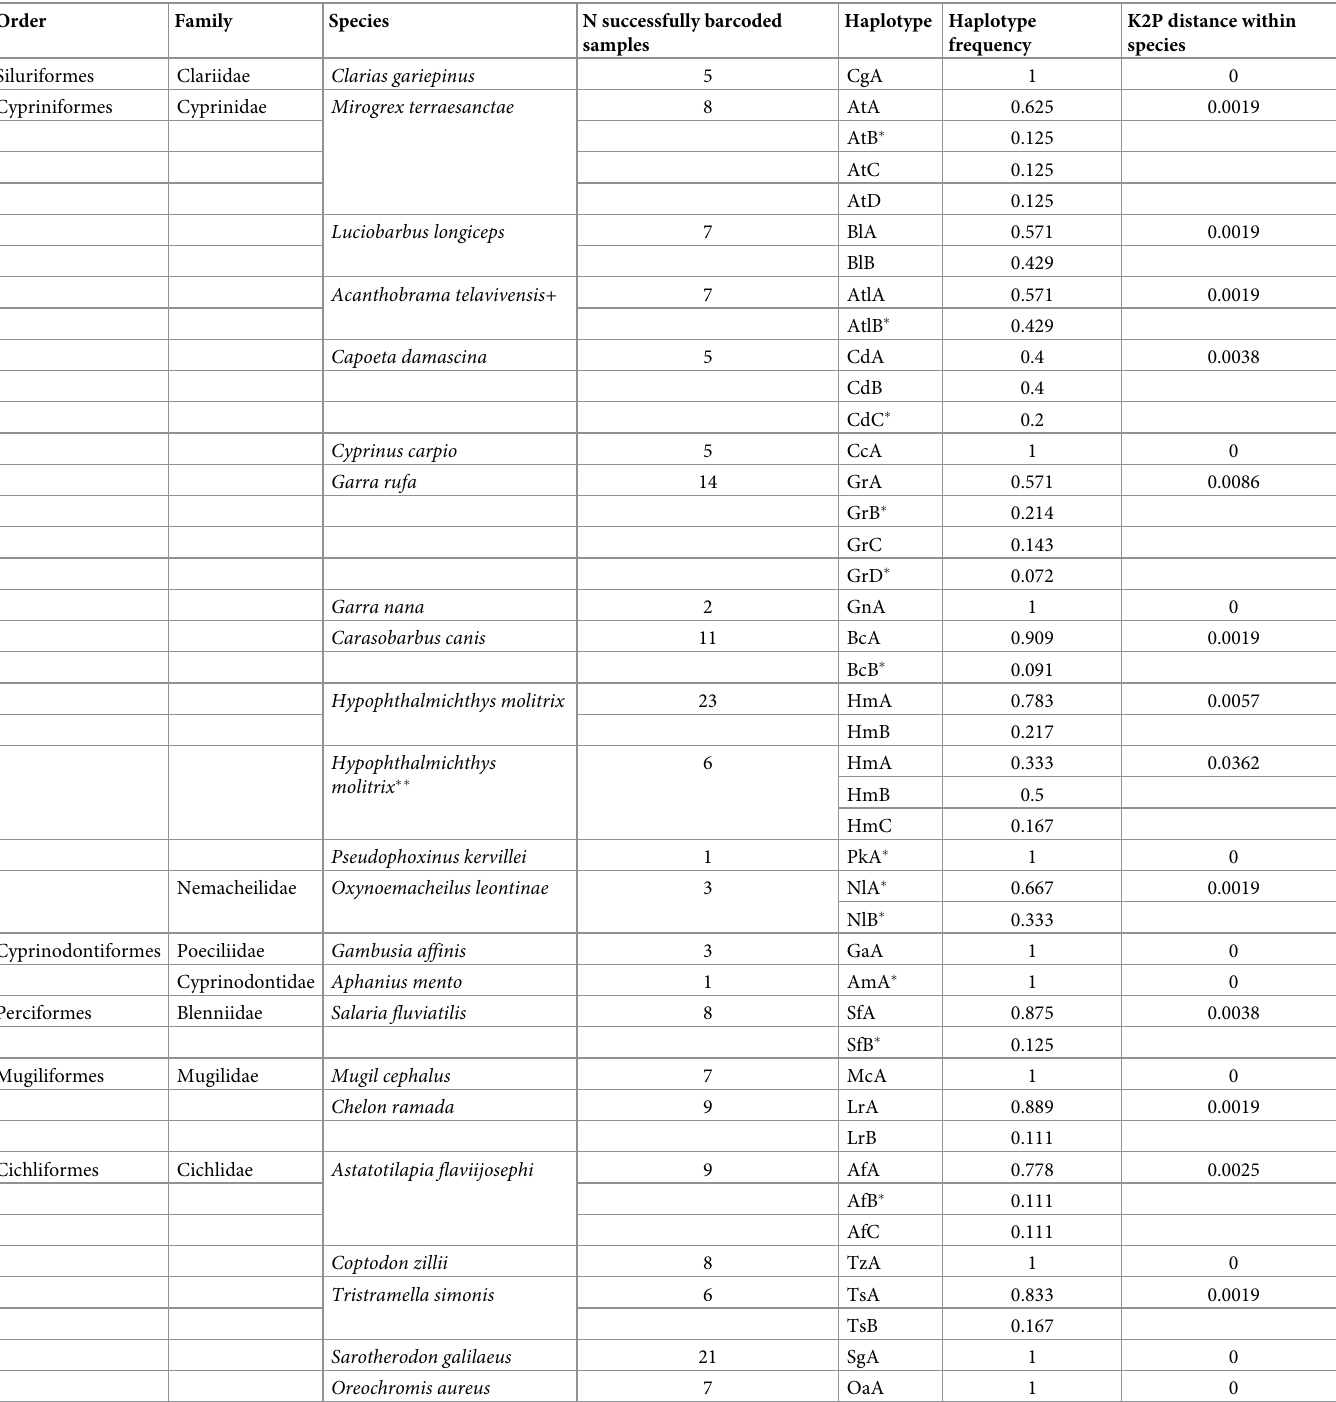
Table 2. Summary of fish species, number of barcoded samples, COI haplotypes naming, haplotype frequencies and within species genetic